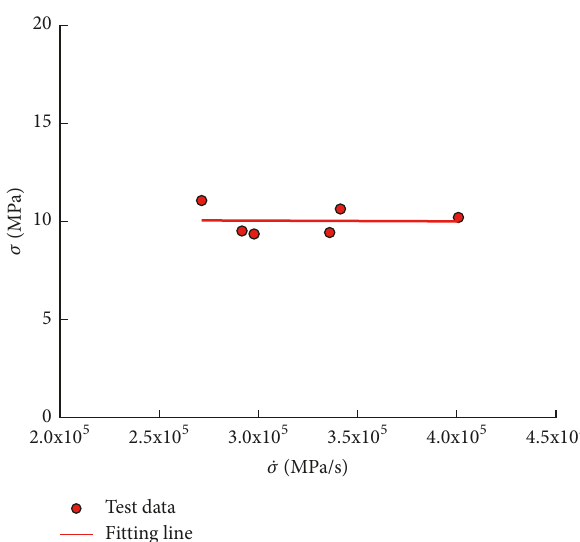
Figure12:Variationinincidenceenergy,reflectiveenergy,transmit- ted energy, and loading rate.